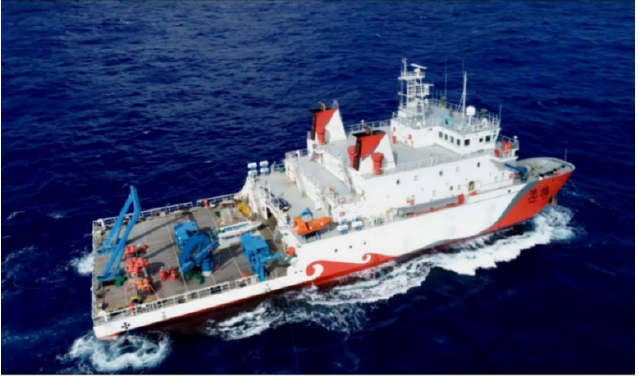
Figure 26. A picture of the ship Shen Kuo.